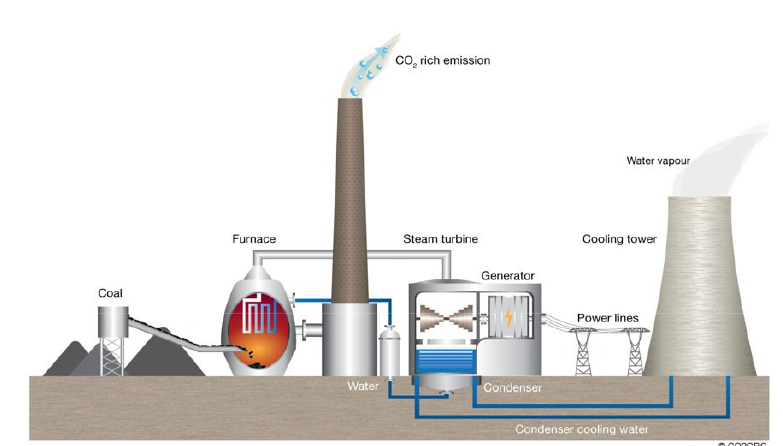
Figure 2. A 2-D representation of a TPP